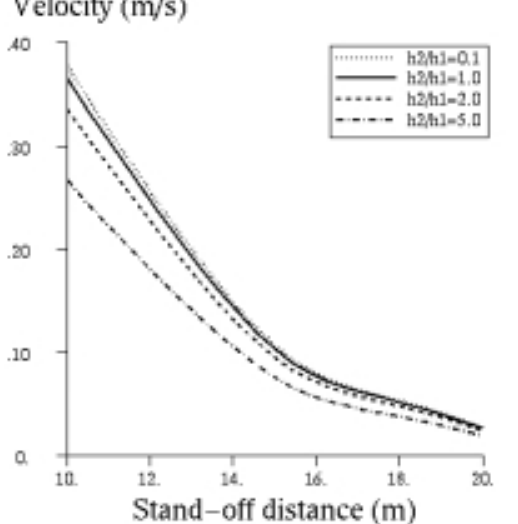
Fig. 8. Variation of central velocity with stand-off distance for dif- ferent thickness ratios.